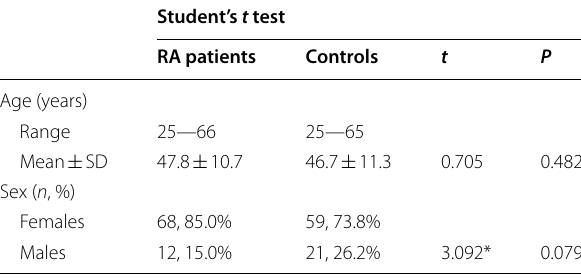
RA rheumatoid arthritis, SD standard deviation * χ 2 value, chi-square test, level of significance at P